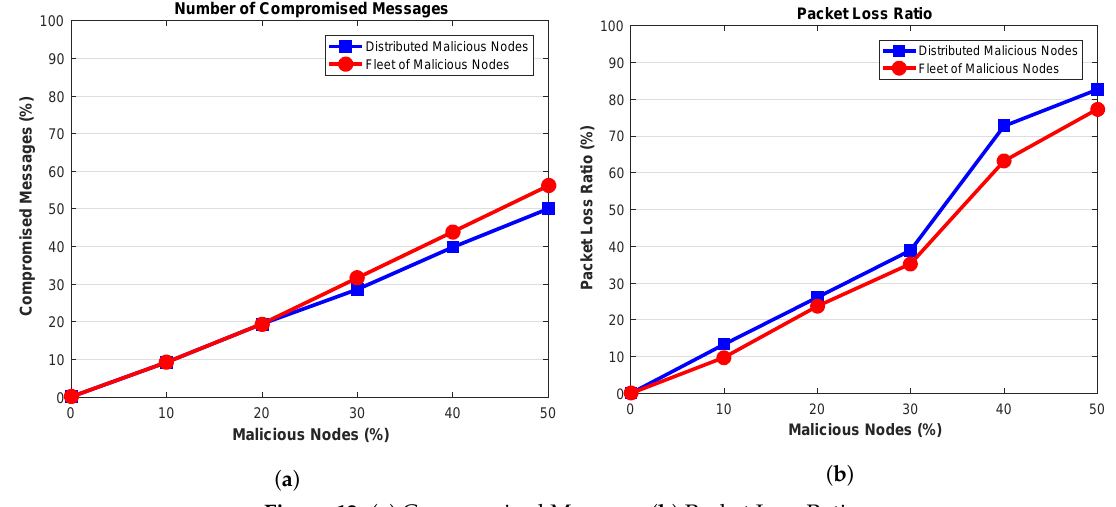
Figure 12. ( a ) Compromised Messages ( b ) Packet Loss